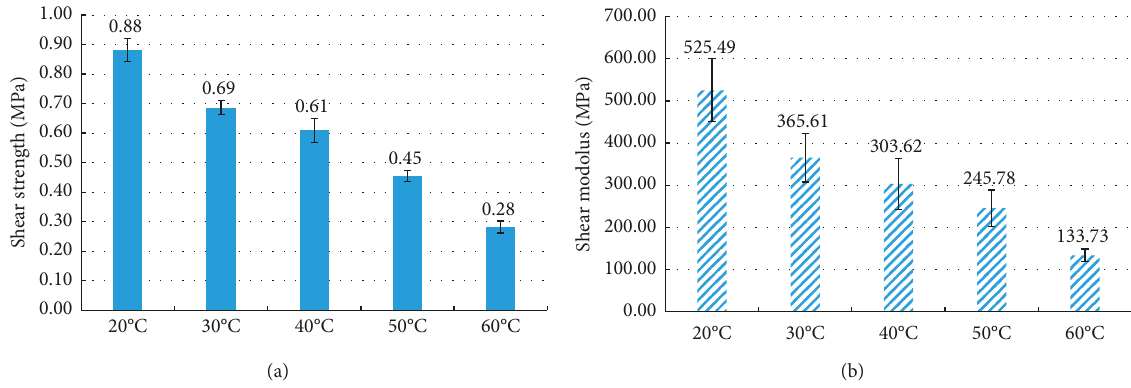
Figure 12: (a) Shear strength and (b) shear modulus at different